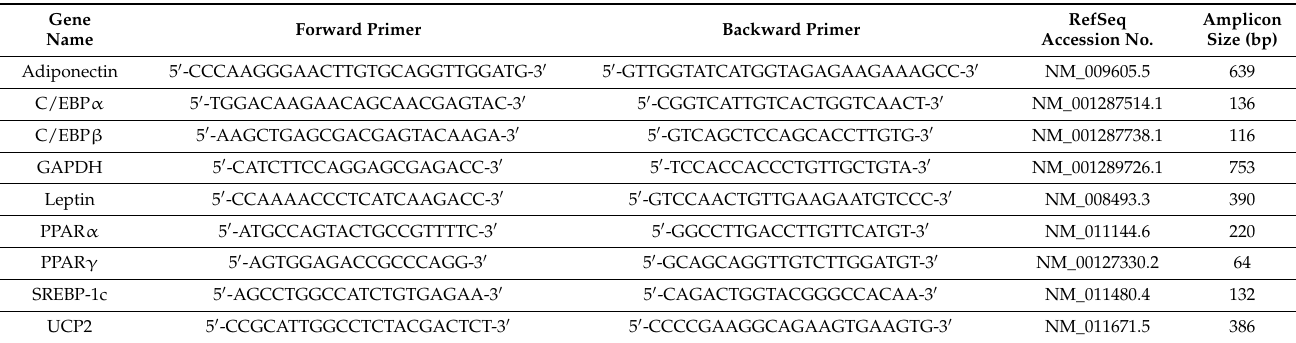
Table 1. Primer sequences used in the present